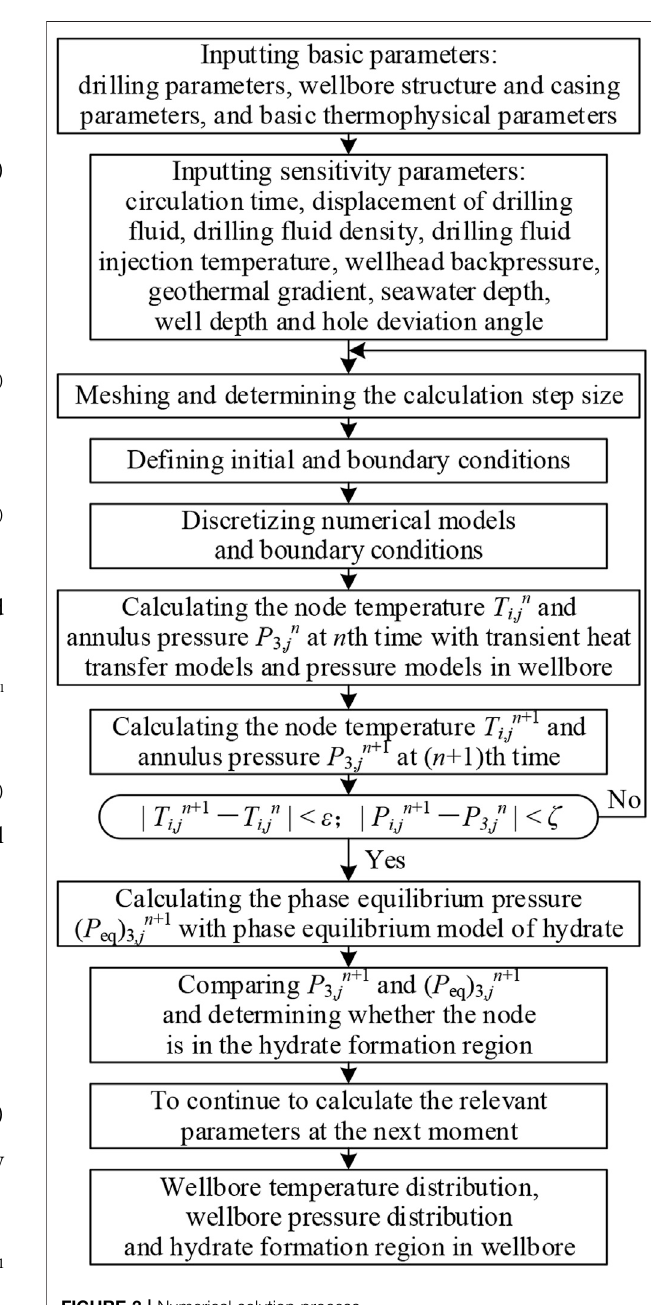
FIGURE 3 | Numerical solution